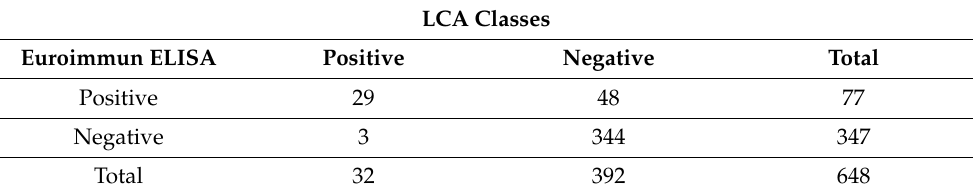
Table 2. Results of Euroimmun ELISA according to the latent class analysis (LCA)